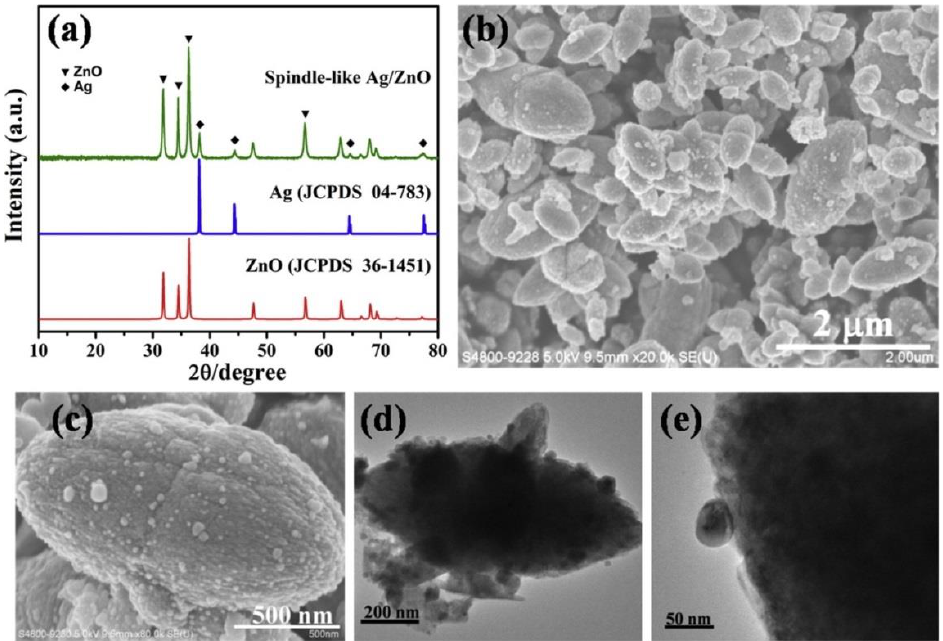
Figure 64. XRD pattern ( a ), SEM ( b , c ) and TEM ( d , e ) images of spindle-like Ag / ZnO nanocomposites. Products synthesised by the microwave and ultrasonic wave combined method. Reprinted from [888], Copyright (2019), with permission from Elsevier [OR APPLICABLE SOCIETY COPYRIGHT OWNER]. All rights reserved. In order to re-use permission must be obtained from the rightsholder.